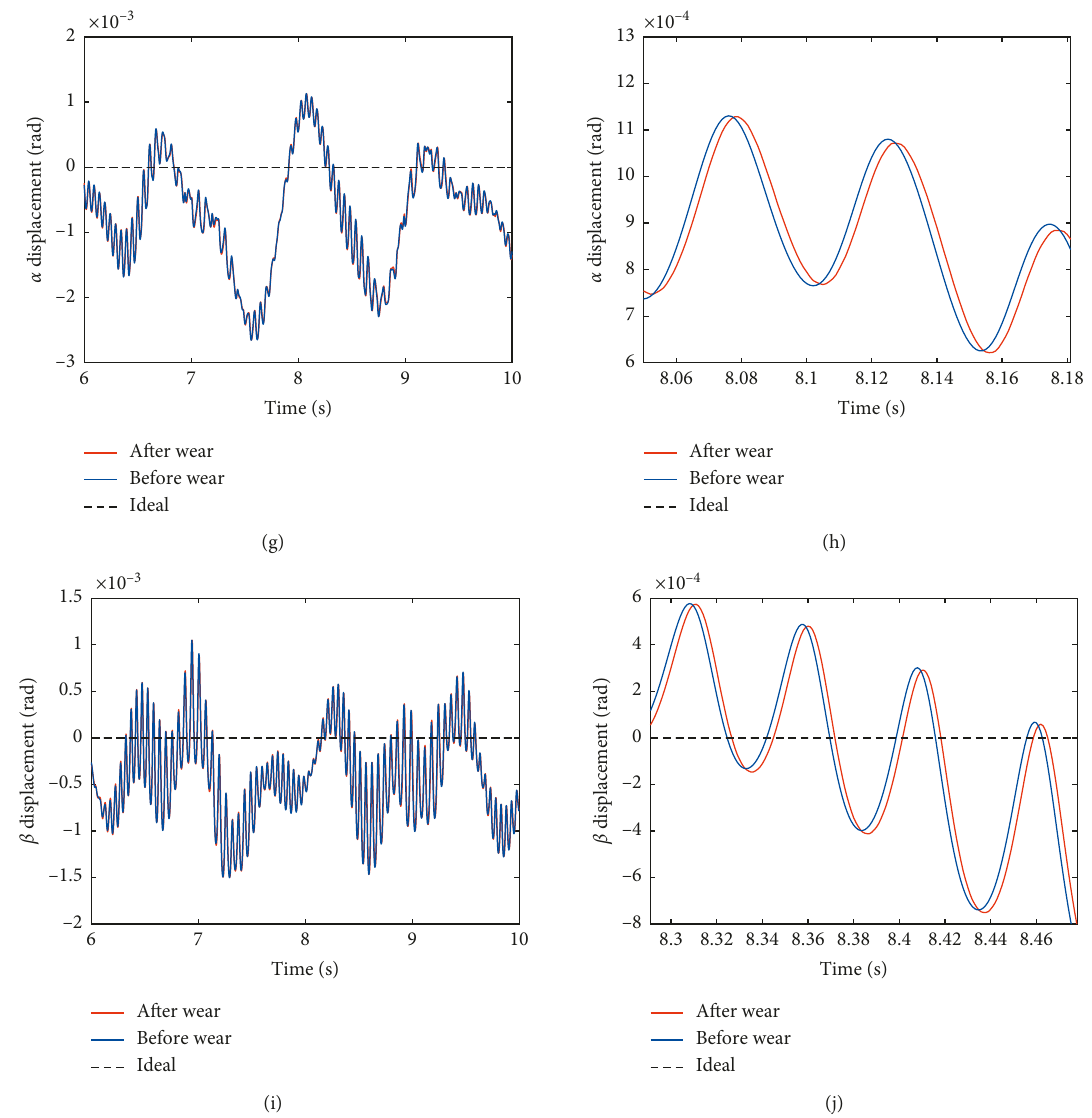
Figure 10: Comparison of displacement curves before and after wear. (a) Displacement curve in X direction, (b) enlarged view of displacement curve in X direction, (c) displacement curve in Y direction, (d) enlarged view of displacement curve in Y direction, (e) displacement curve in Z direction, (f) enlarged view of displacement curve in Z direction, (g) angular displacement curve in α direction, (h) enlarged view of angular displacement curve in α direction, (i) angular displacement curve in β direction, and (j) enlarged view of angular displacement curve in β